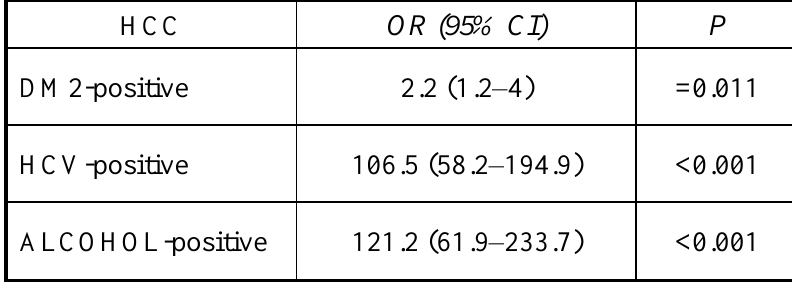
Table 4. Multivariate analysis for HCC risk.